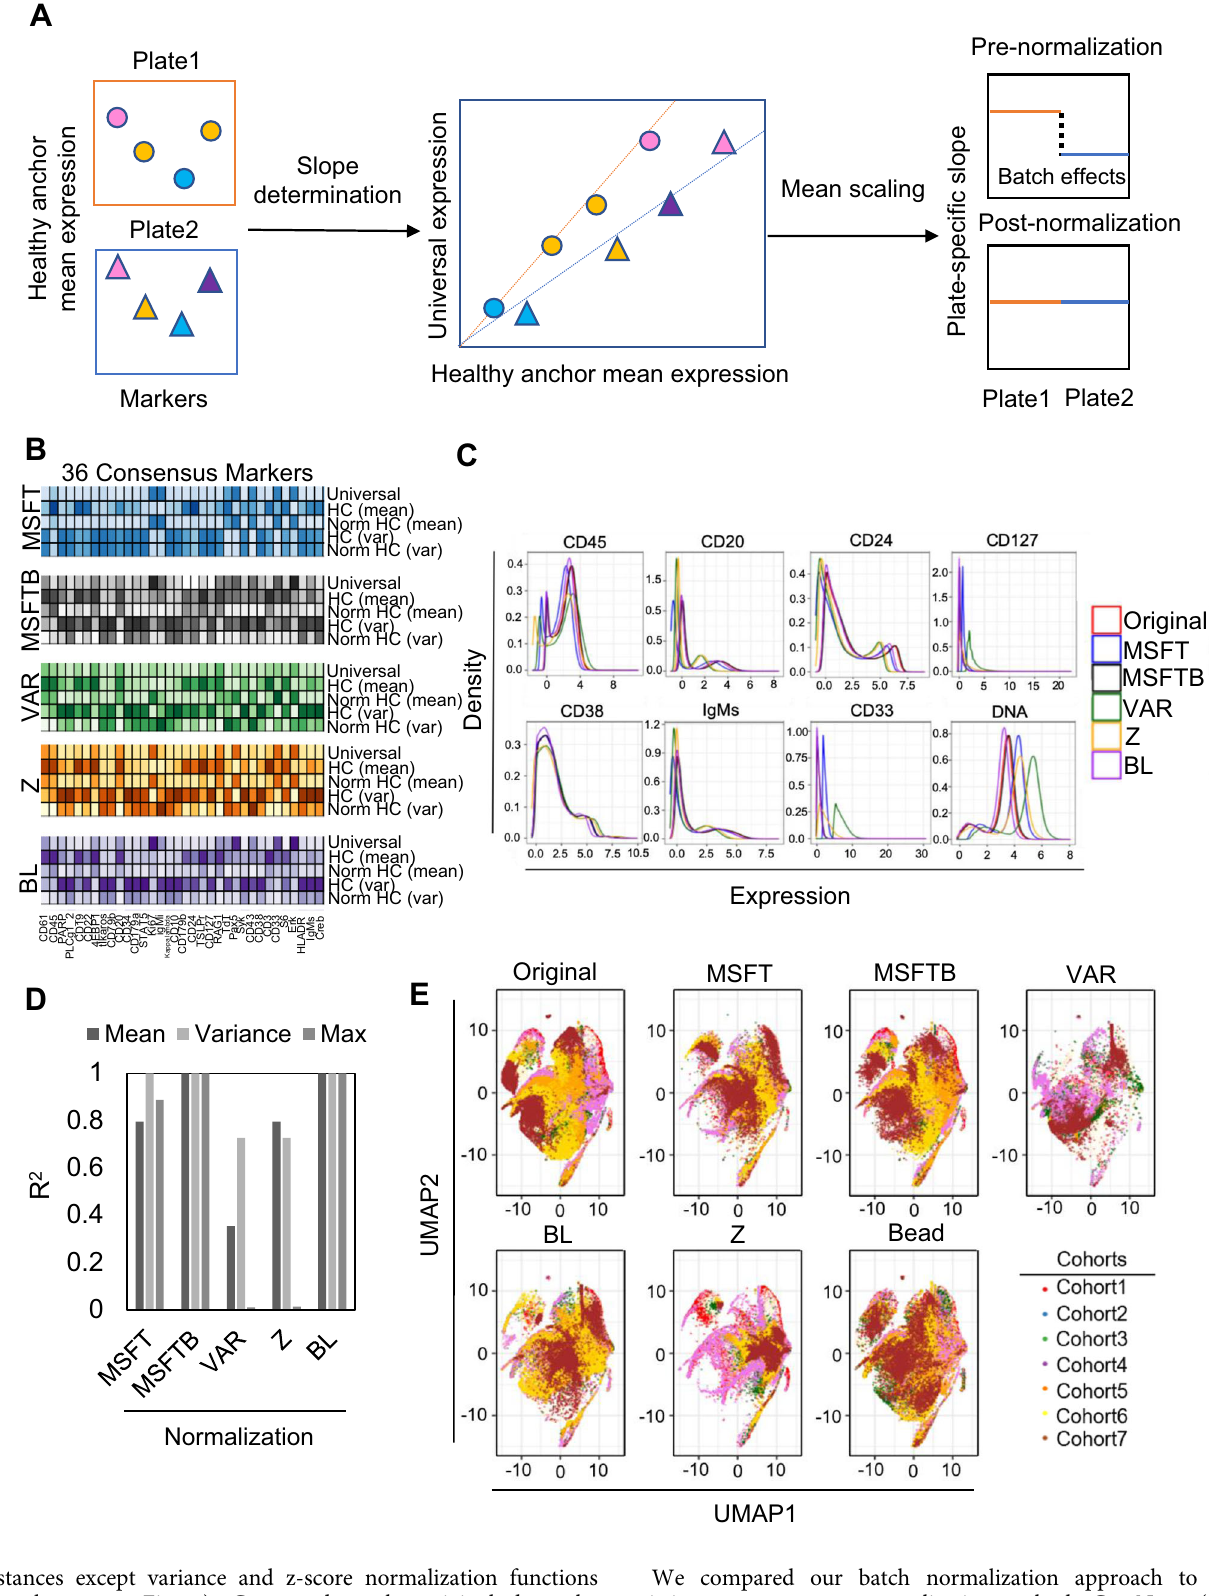
distances except variance and z-score normalization functions (Supplementary Fig. 5). Compared to the original data, the average cell-cell distances between and within cohorts became closer after our CytofIn normalization procedure. Interestingly, MSFTB normalization attained the most similar cell-cell distance changes to that by the bead normalization.